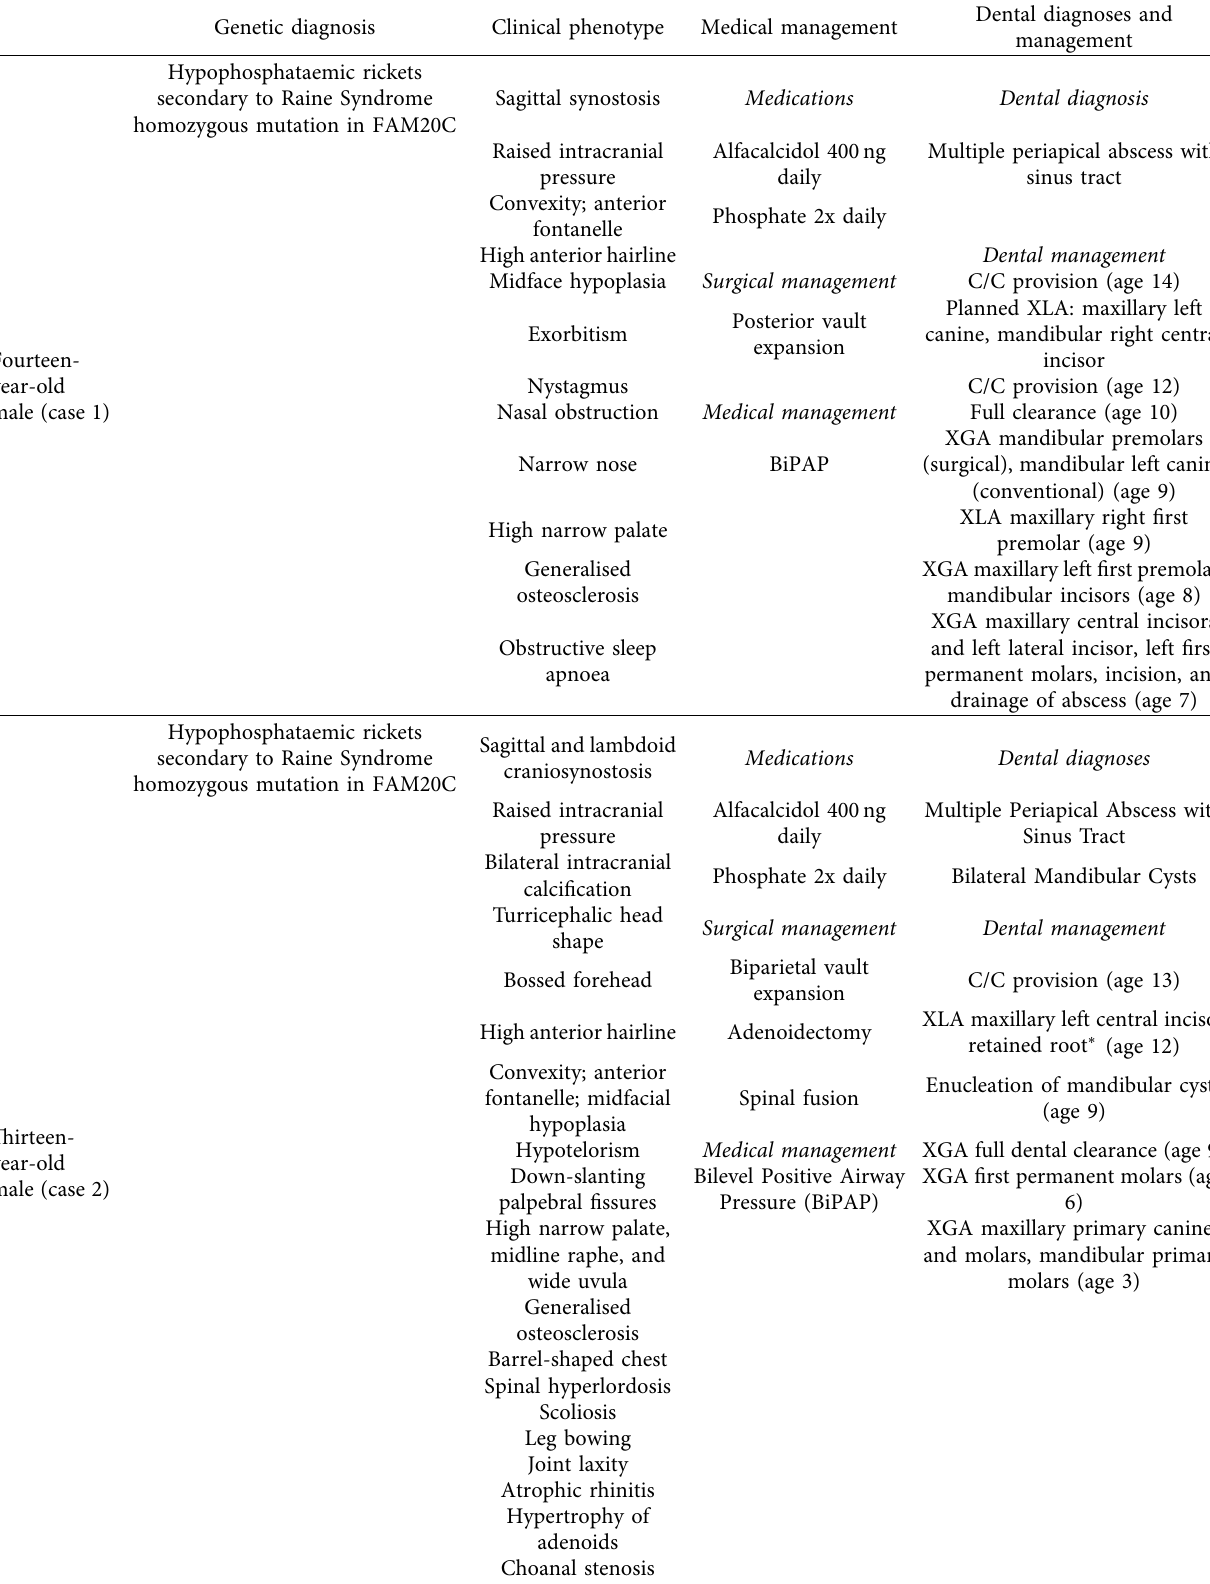
Table 1: A summary of the genetic, medical, and dental diagnoses of the three siblings and their dental